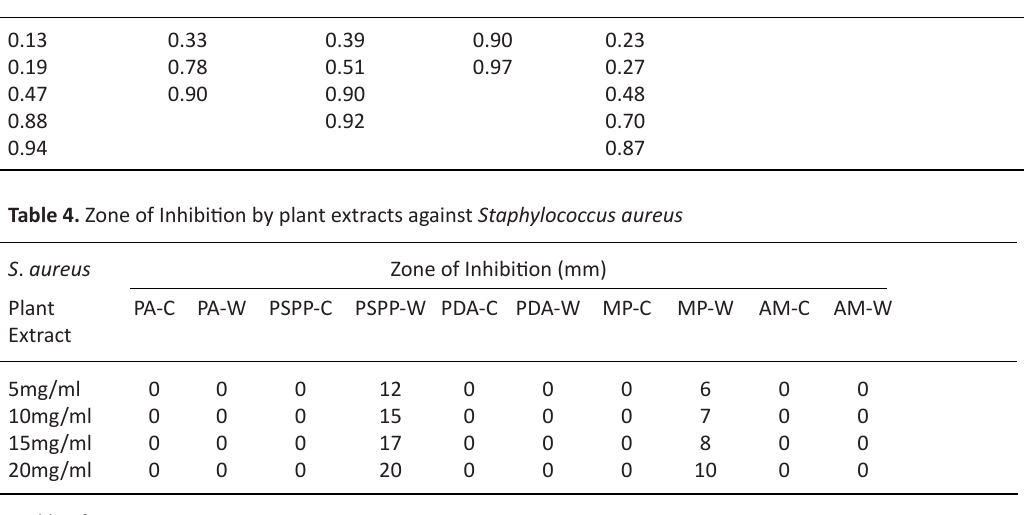
value of compounds separated from aqueous plant extracts Table 3. R f P. acidus